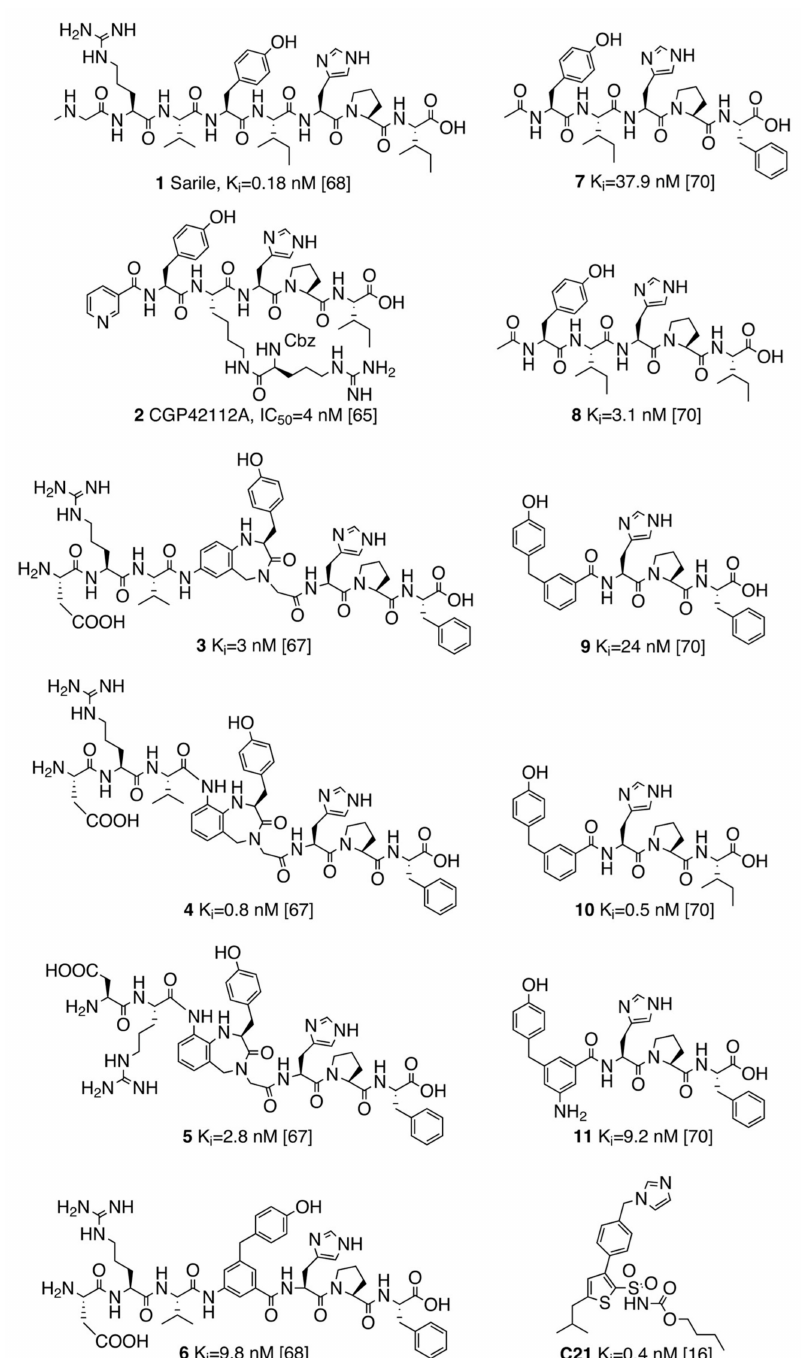
Figure 1. Structures of all the peptides considered in this study. Left column collects the octapeptides and analogues. On the right column, truncated pentapeptides and analogues are depicted. Binding a ffi nities to angiotensin II receptor type 2 (AT2R) are shown (K i and IC 50 values, in nM) with references. The corresponding binding a ffi nities to angiotensin II receptor type 1 (AT1R) are: 1 (K i 0.16 nM), 2 (IC 50 > 10,000 nM), 3 (K i > 10,000 nM), 4 (K i > 10,000 nM), 5 (K i > 10,000 nM), 6 (K i 30,3 nM), 7 (K i > 10,000 nM), 8 (K i > 10,000 nM), 9 (K i 196 nM), 10 (K i > 10,000 nM), 11 (K i > 10,000